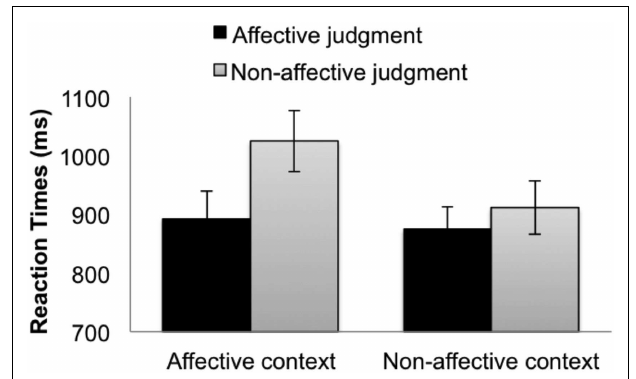
FIGURE 1 | Reaction times for the (picture) targets when participants made affective judgments (black bars) and non-affective judgments (gray bars) in the affective context group (left bars) and the non-affective context group (right bars). The error bars indicate subject-wise SEM.